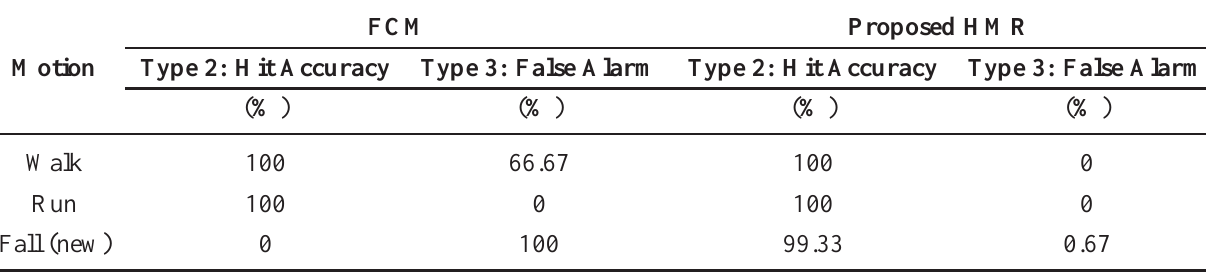
Table 1. Performance metrics results for FCM and proposed HMR.